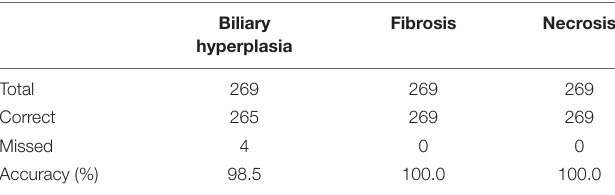
TABLE 7 | Performance of single-task DNN in predicting Eun et al. data. Biliary Fibrosis hyperplasia